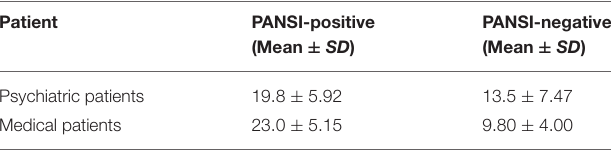
Table 2 . There was a statistically significant association between PANSI-negative and patient status (estimate = 0.120, p < 0.05, OR = 1.128, 95% CI = 1.1, 1.2). This indicates positive